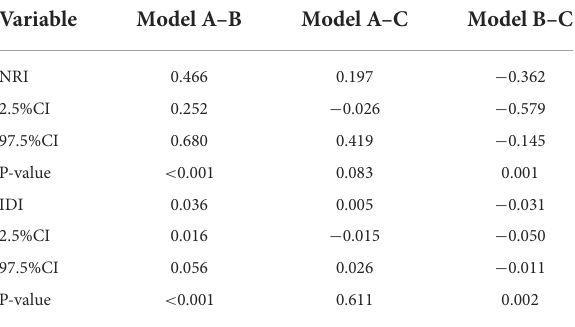
TABLE 3 Comparison of the prediction ability among different models through NRI and